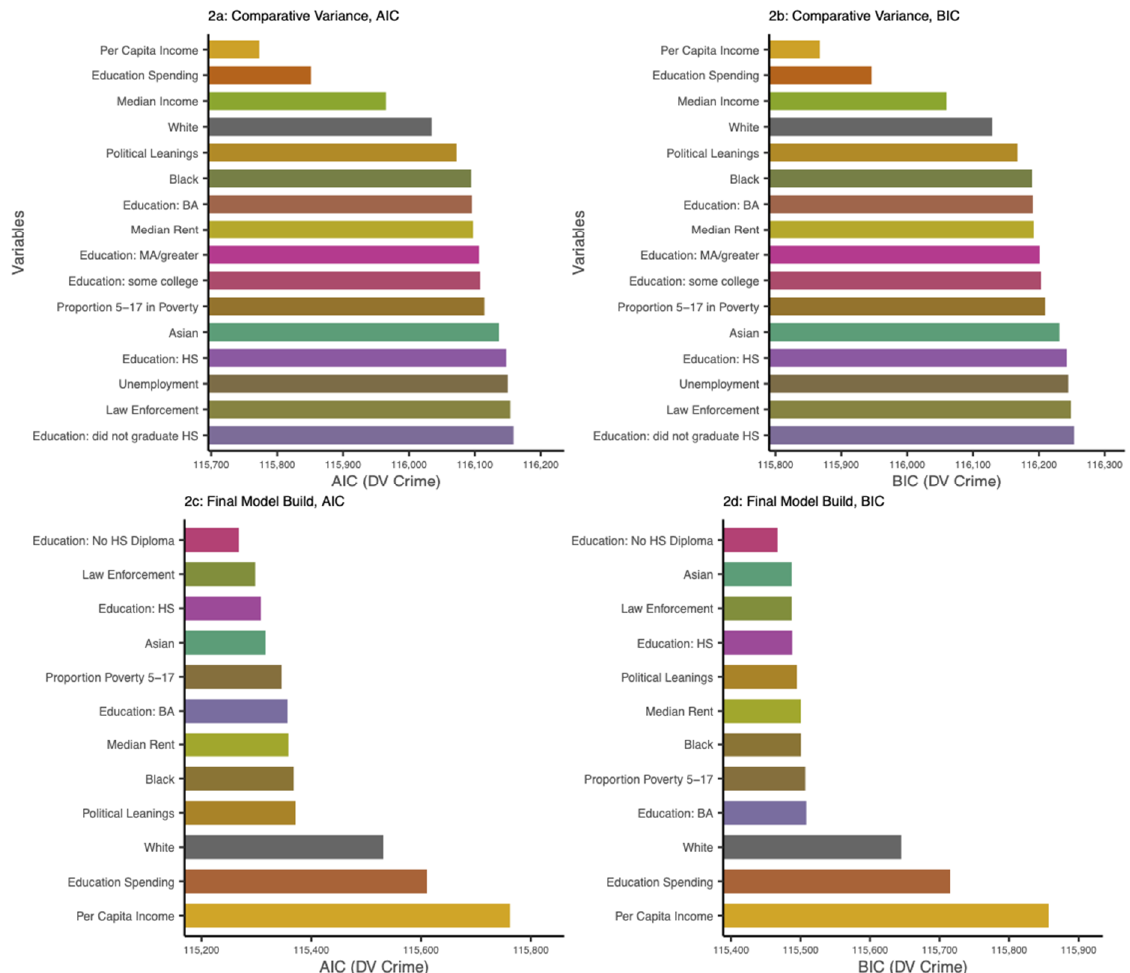
Figure 2. Though we predominantly hold to AIC for its preference in predictive tasks (as BIC can result in underfitting), here we include both AIC and BIC to demonstrate the minimal difference between the two criterions. ( a ) AIC values for individual variables in mixed effect models controlling for covariates of population and population density. ( b ) Corresponding BIC values. ( c ) Final model represents the order in which we added predictor variables. Given that we imputed missing data, all AIC and BIC values in each figure are comparable. ( d ) Corresponding BIC values. DV: dependent variable.